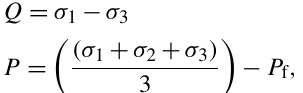
Figure 1. Cam-cap yield envelope showing the relationship be- tween the stress state at the point of inelastic yielding and the type and orientation of the deformation band that nucleates. In horizontal contraction, higher effective mean stresses are predicted, resulting in the formation of bands characterised by low shear-to-compaction ratios. Comparatively, during horizontal extension, higher differ- ential stresses are predicted, resulting in bands characterised by high shear-to-compaction ratios. The yield envelope shrinks with increased porosity and/or grain size of the material. Adapted from Fossen et al.